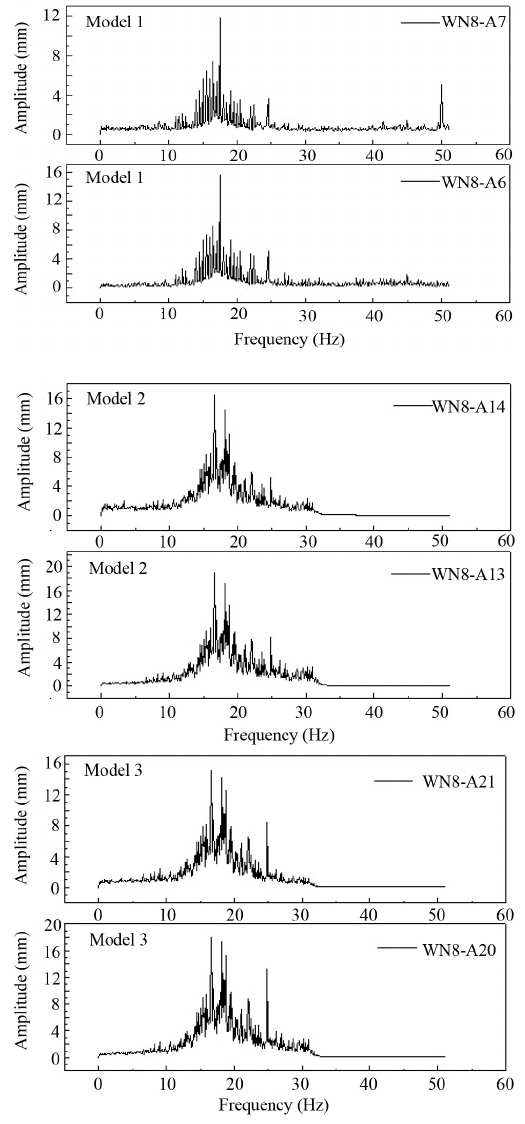
Figure 8. White noise spectral analysis of three models.